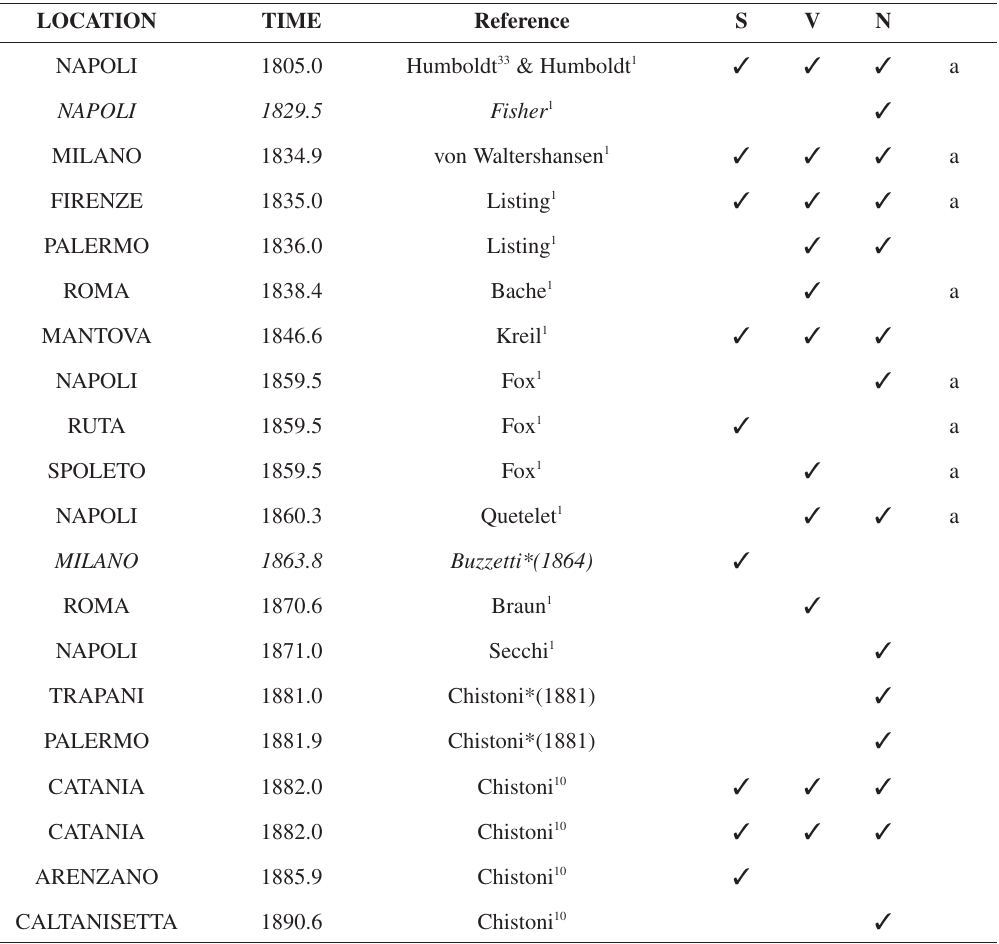
Table II. Intensity data from the Historical Italian Geomagnetic Data Catalogue (Cafarella et al. , 1992a) that fail to lie below the line of assumable relocation error for at least one of the three relocation centres: La Spezia (S), Viterbo (V) or Naples (N). Failure is indicated by ✓ sign. Values in italics indicate that the corresponding direc- tional data (table I) also failed. References are labelled according to Cafarella et al. (1992a).